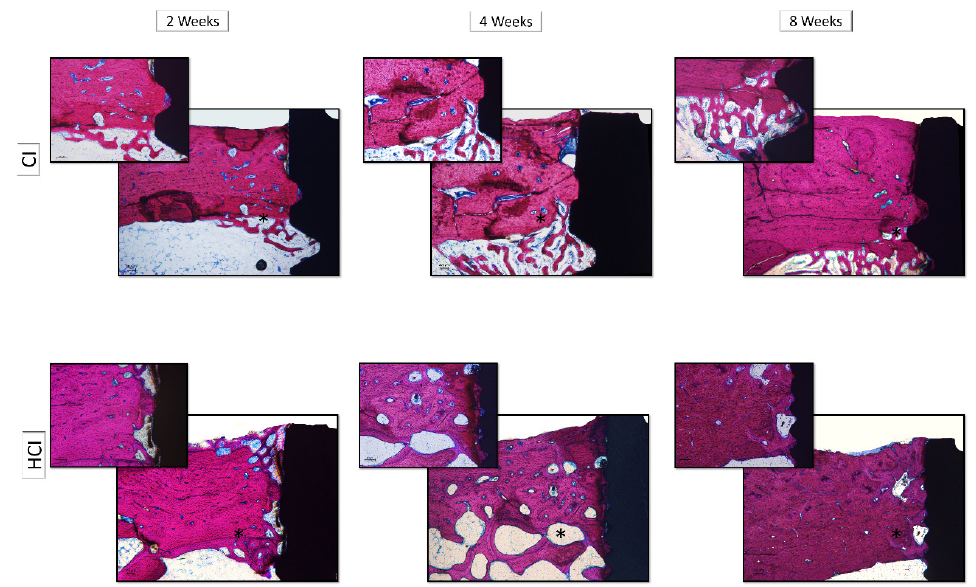
Figure 9. Histological images representative of the non-decalcified sections of the implants with different macrostructures and in different experimental periods. CI: Cylindrical Implant and HCI: Hybrid Conical Implant. Both in the periods of 2, 4 and 8 weeks. 5× and 10× magnification.